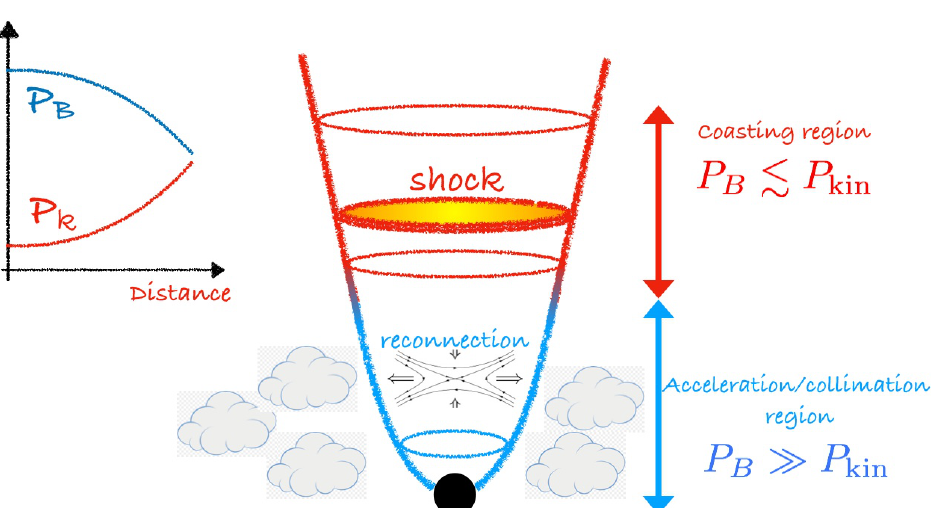
Figure 2. A possible global scenario for dissipation and particle acceleration in relativistic jets. The jet starts as a magnetically dominated flow which progressively accelerates. In this region the main channel for energy dissipation is magnetic reconnection, likely triggered by current-driven instabilities. During the acceleration phase, the magnetic energy is converted into kinetic bulk energy (schematic plot on the left) until substantial equipartition is reached. At larger distances the reduced magnetization of the flow allows efficient particle acceleration by